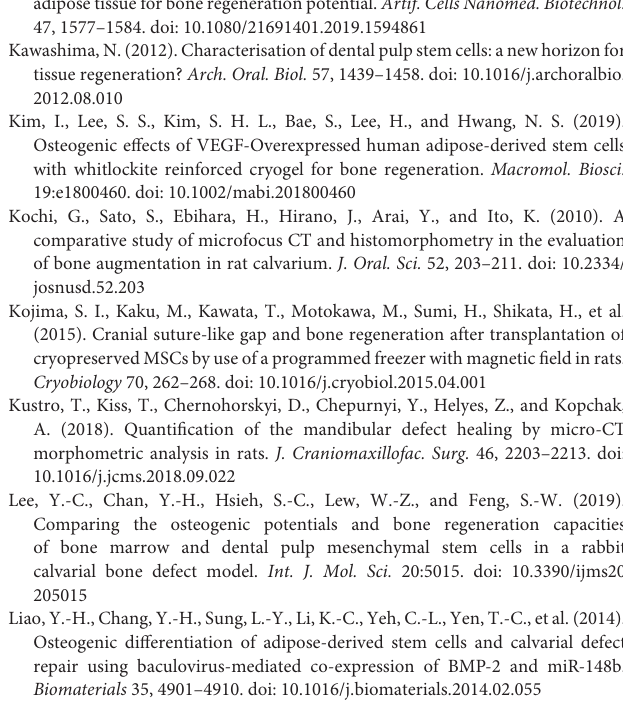
Supplementary Figure 1 | Characterization of surface marker profiles for ADSCs and DPSCs prior to and after cryopreservation. The flow cytometry results revealed that the ADSCs and DPSCs were always positive for CD73, CD90, and CD105, but negative for CD34, CD45, and HLA-DR. Supplementary Figure 2 | Calvarial bone repair at 8 weeks in Control, Bio-Oss Collagen, Bio-Oss Collagen + ADSCs and Bio-Oss Collagen + DPSCs groups. (a) Hematoxylin and eosin (H&E) stained images. (b) New bone area percentages in the defect region as assessed by histomorphometric analyses. (c) Immunohistochemical staining specific for osteocalcin (OCN). (d) OCN immunostaining percentages as assessed by DAB total area/tissue total area analyses. Data are presented as the mean ± standard deviation, ∗ P < 0.05, ∗∗ P <